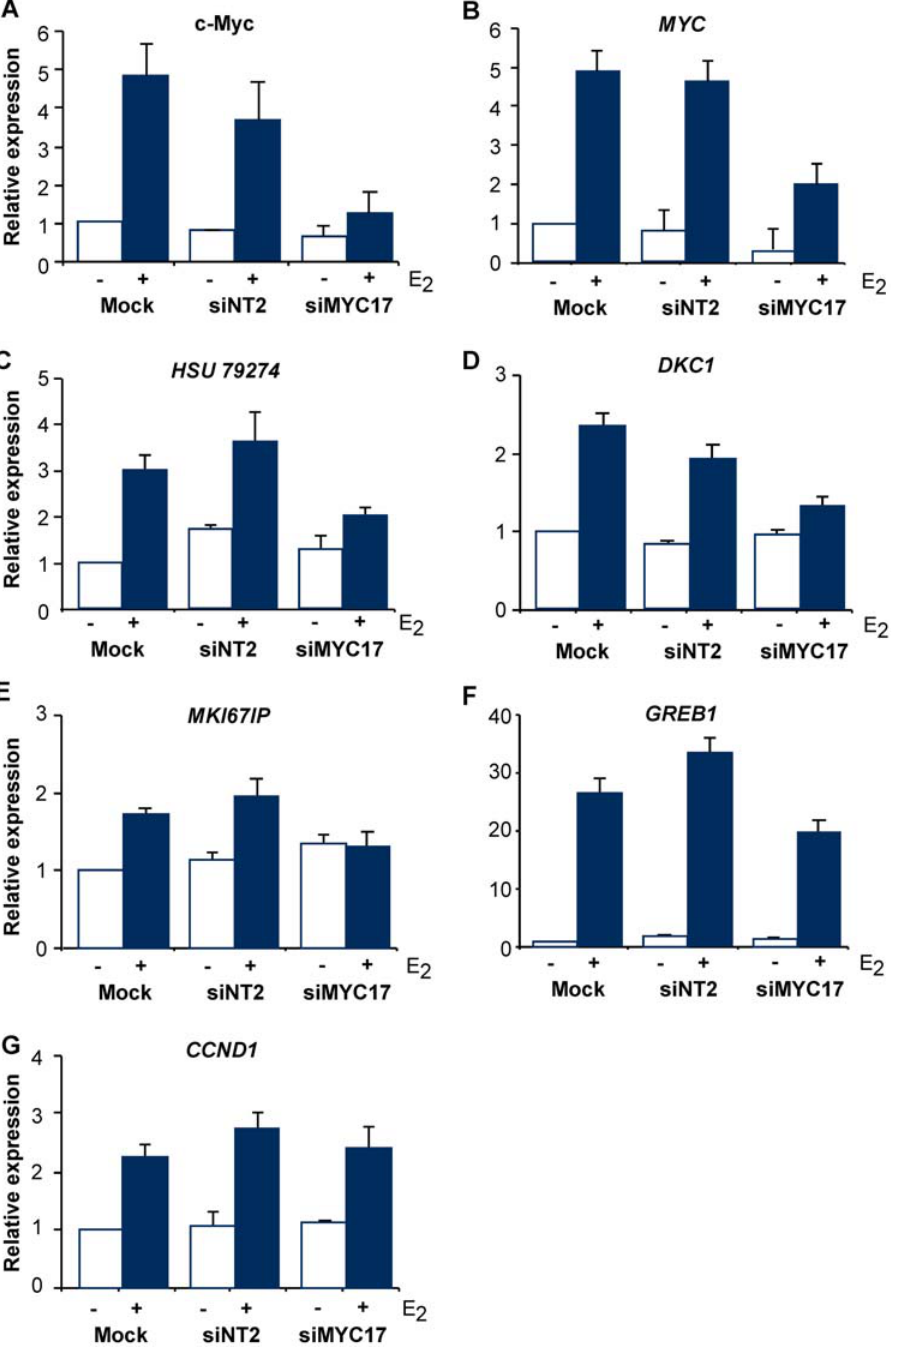
Figure 4. Effect of RNAi-mediated knockdown of c-Myc on regulation of selected genes after estrogen treatment. Cells were mock- transfected or transfected with 50 nM of control (non-targetting siRNA, siNT2) or Myc siRNA (siMYC17), treated with antiestrogen (ICI 182780) for 48 h, and then treated with E 2 for 6 h (A) or 9 h (B–G). (A) Protein lysates were immunoblotted for c-Myc 6 h after E 2 treatment and quantitated by densitometry. Data are the mean 6 range or SEM of 2–3 experiments. (B–G) For the indicated genes, mRNA levels were quantitated by qRT-PCR and are presented as the mean 6 SEM of 3 experiments.